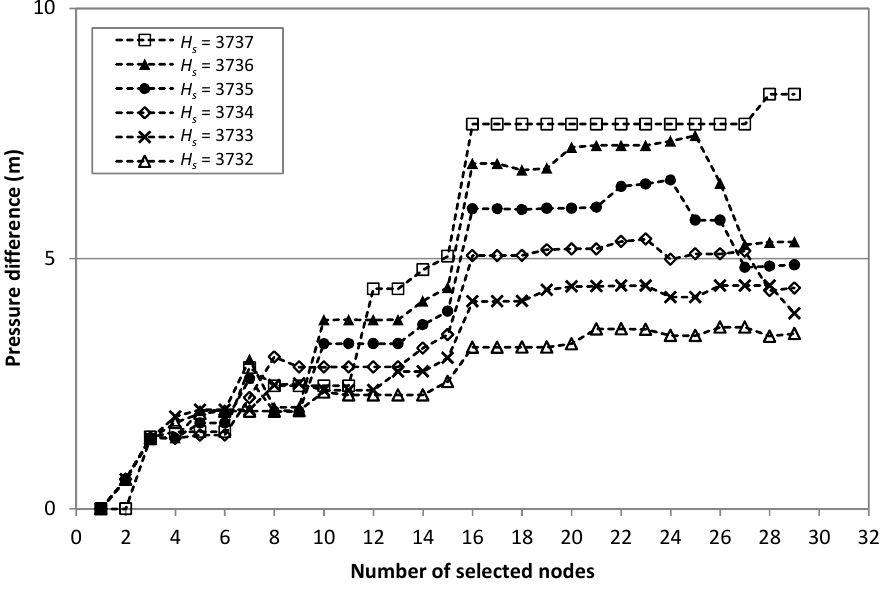
Figure 9. Variation of the pressure difference as a function of the selected nodes and the head in the water supply source.